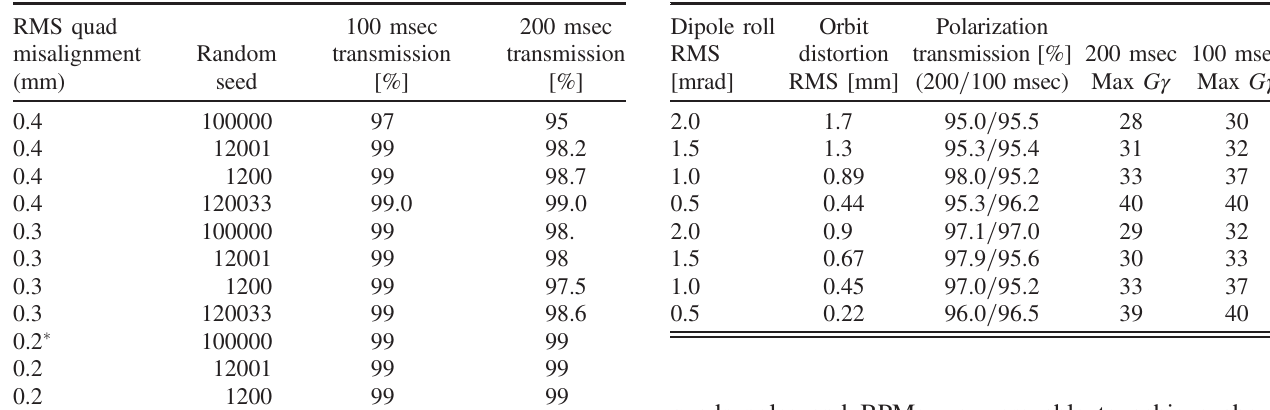
TABLE II. Polarization transmission to 18 GeV for random gaussian quadrupole misalignments with SVD orbit correction for 4 different random seeds. * indicates tests with bpm misalign- ments of 0.2 mm rms.